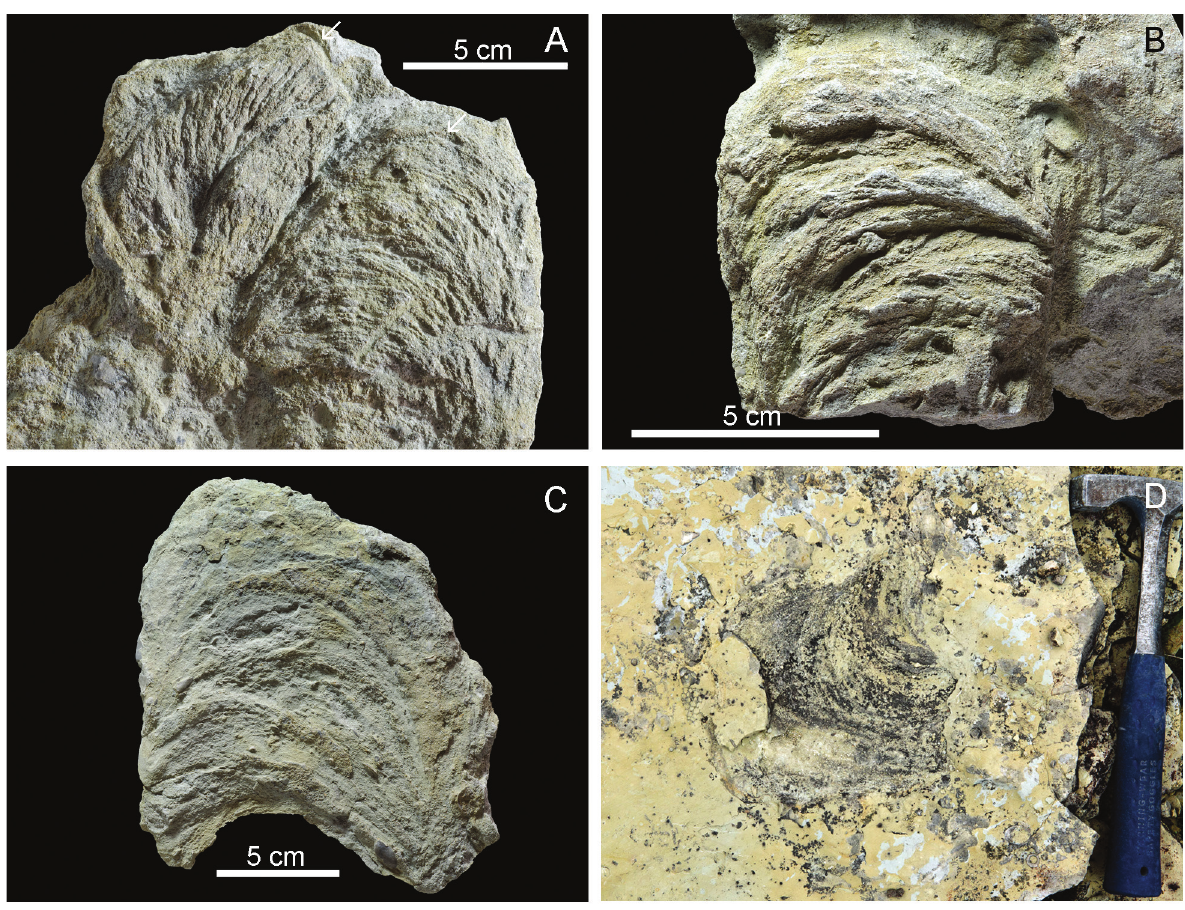
Fig. 2. A , B , Zoophycos isp. from the Kaugatuma Formation (lower Pridoli) from Saaremaa, Kaugatuma (TUG 362-45 and 362-50). Arrows point to the marginal tube. C , Zoophycos isp. from the Kuressaare Formation (Ludfordian) from Saaremaa, Kudjape (TUG 362-44). D , Zoophycos isp. from the Raikküla Regional Stage (Llandovery) of middle Estonia, Kalana quarry. Hammer for scale is 28